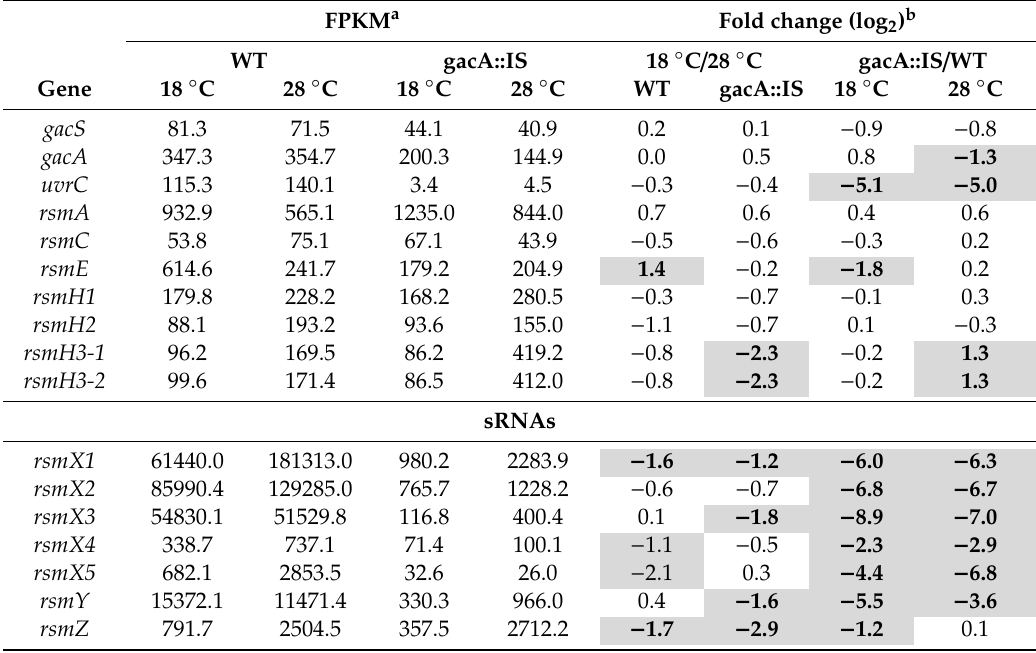
Table 2. RNAseq expression values of genes from the GacS / GacA and Csr / Rsm transcriptional regulation systems from P. amygdali pv. phaseolicola